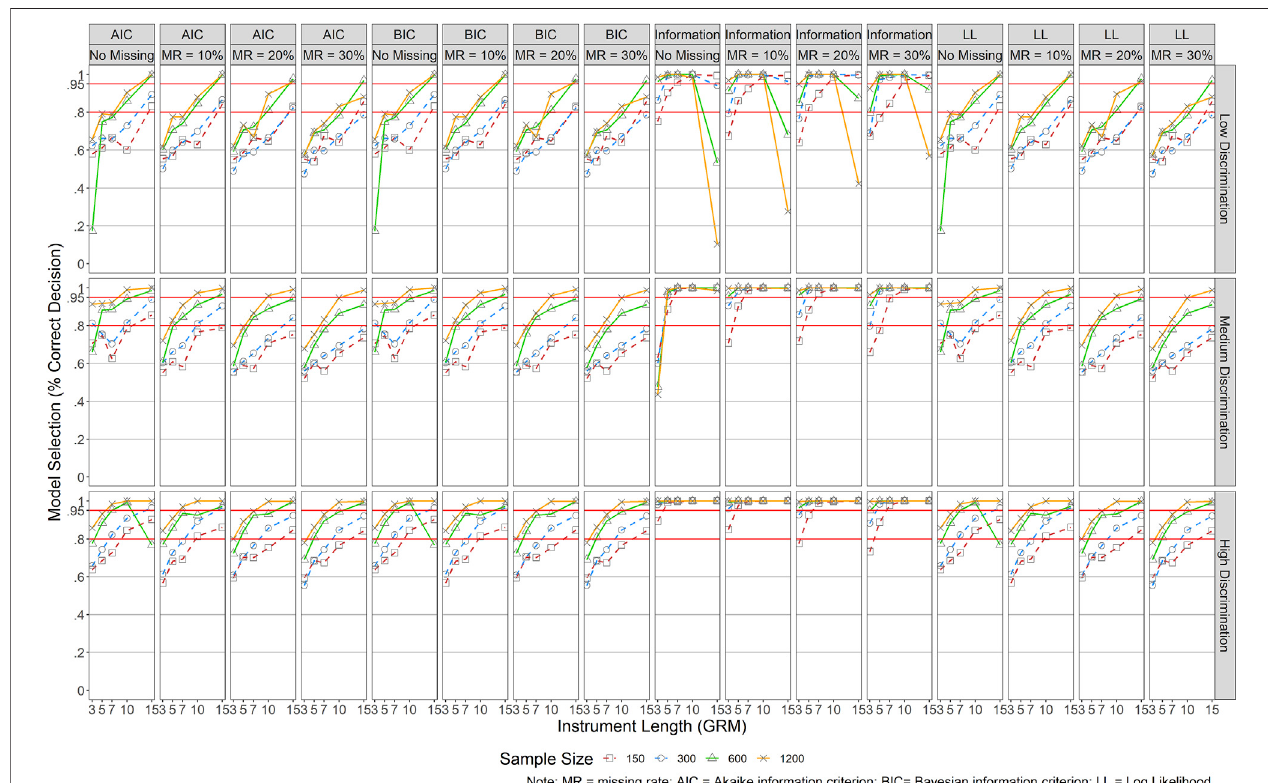
FIGURE 10 | Results of Model Speci fi cation/Selection for GRM. Note. MR (cid:1) missing rate; AIC (cid:1) Akaike information criterion; BIC (cid:1) Bayesian information criterion; LL (cid:1) Log